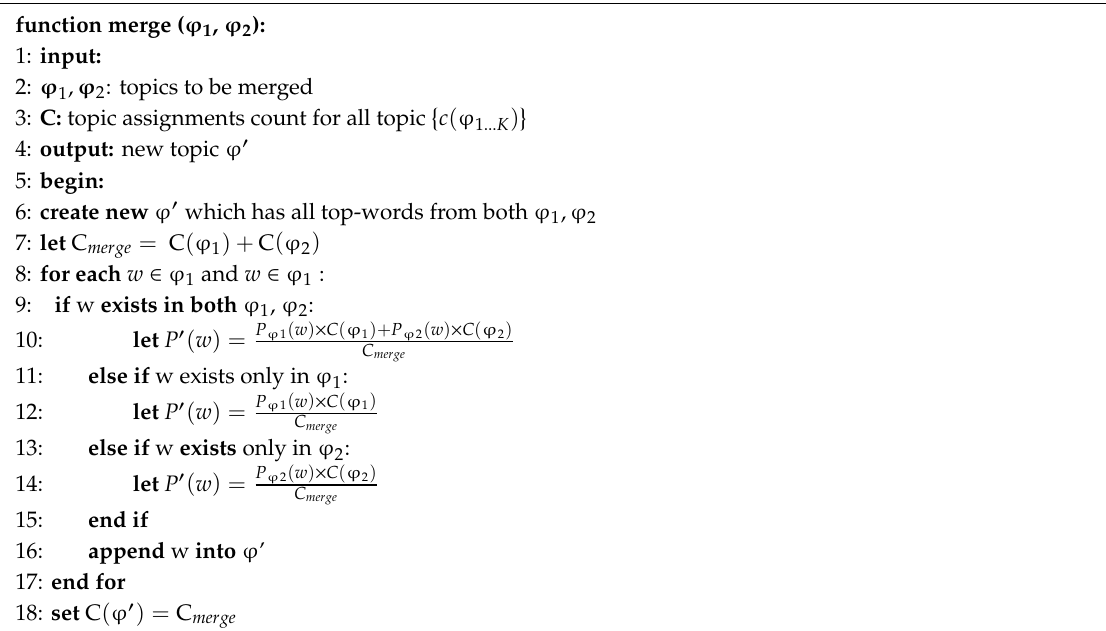
Figure 6. Aggregated topic model plate notation and schema. Algorithm 1. Merge function to form the aggregated